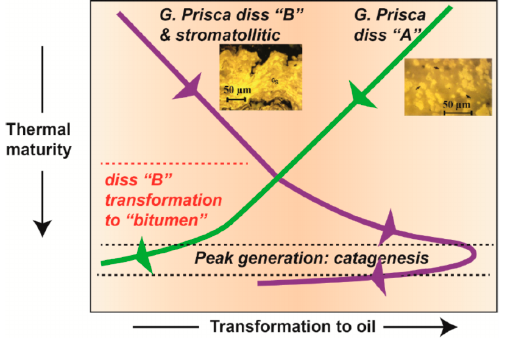
Figure 8. Model of petroleum generation for Yeoman Formation (Saskatchewan, Canada) G. prisca alginite [77]. Thin-walled G. prisca disseminated A contribute to pre-catagenic petroleum products. In contrast, thick-walled disseminated B alginite and stromatolitic G. prisca undergo a structural transformation into a bitumen-like maceral with increasing thermal maturity. Adjacent photomicrographs are those of G. prisca disseminated A and stromatolitic G. prisca alginite. Modified after figure 10 in Stasiuk et al. [77] with copyright permission from Elsevier.